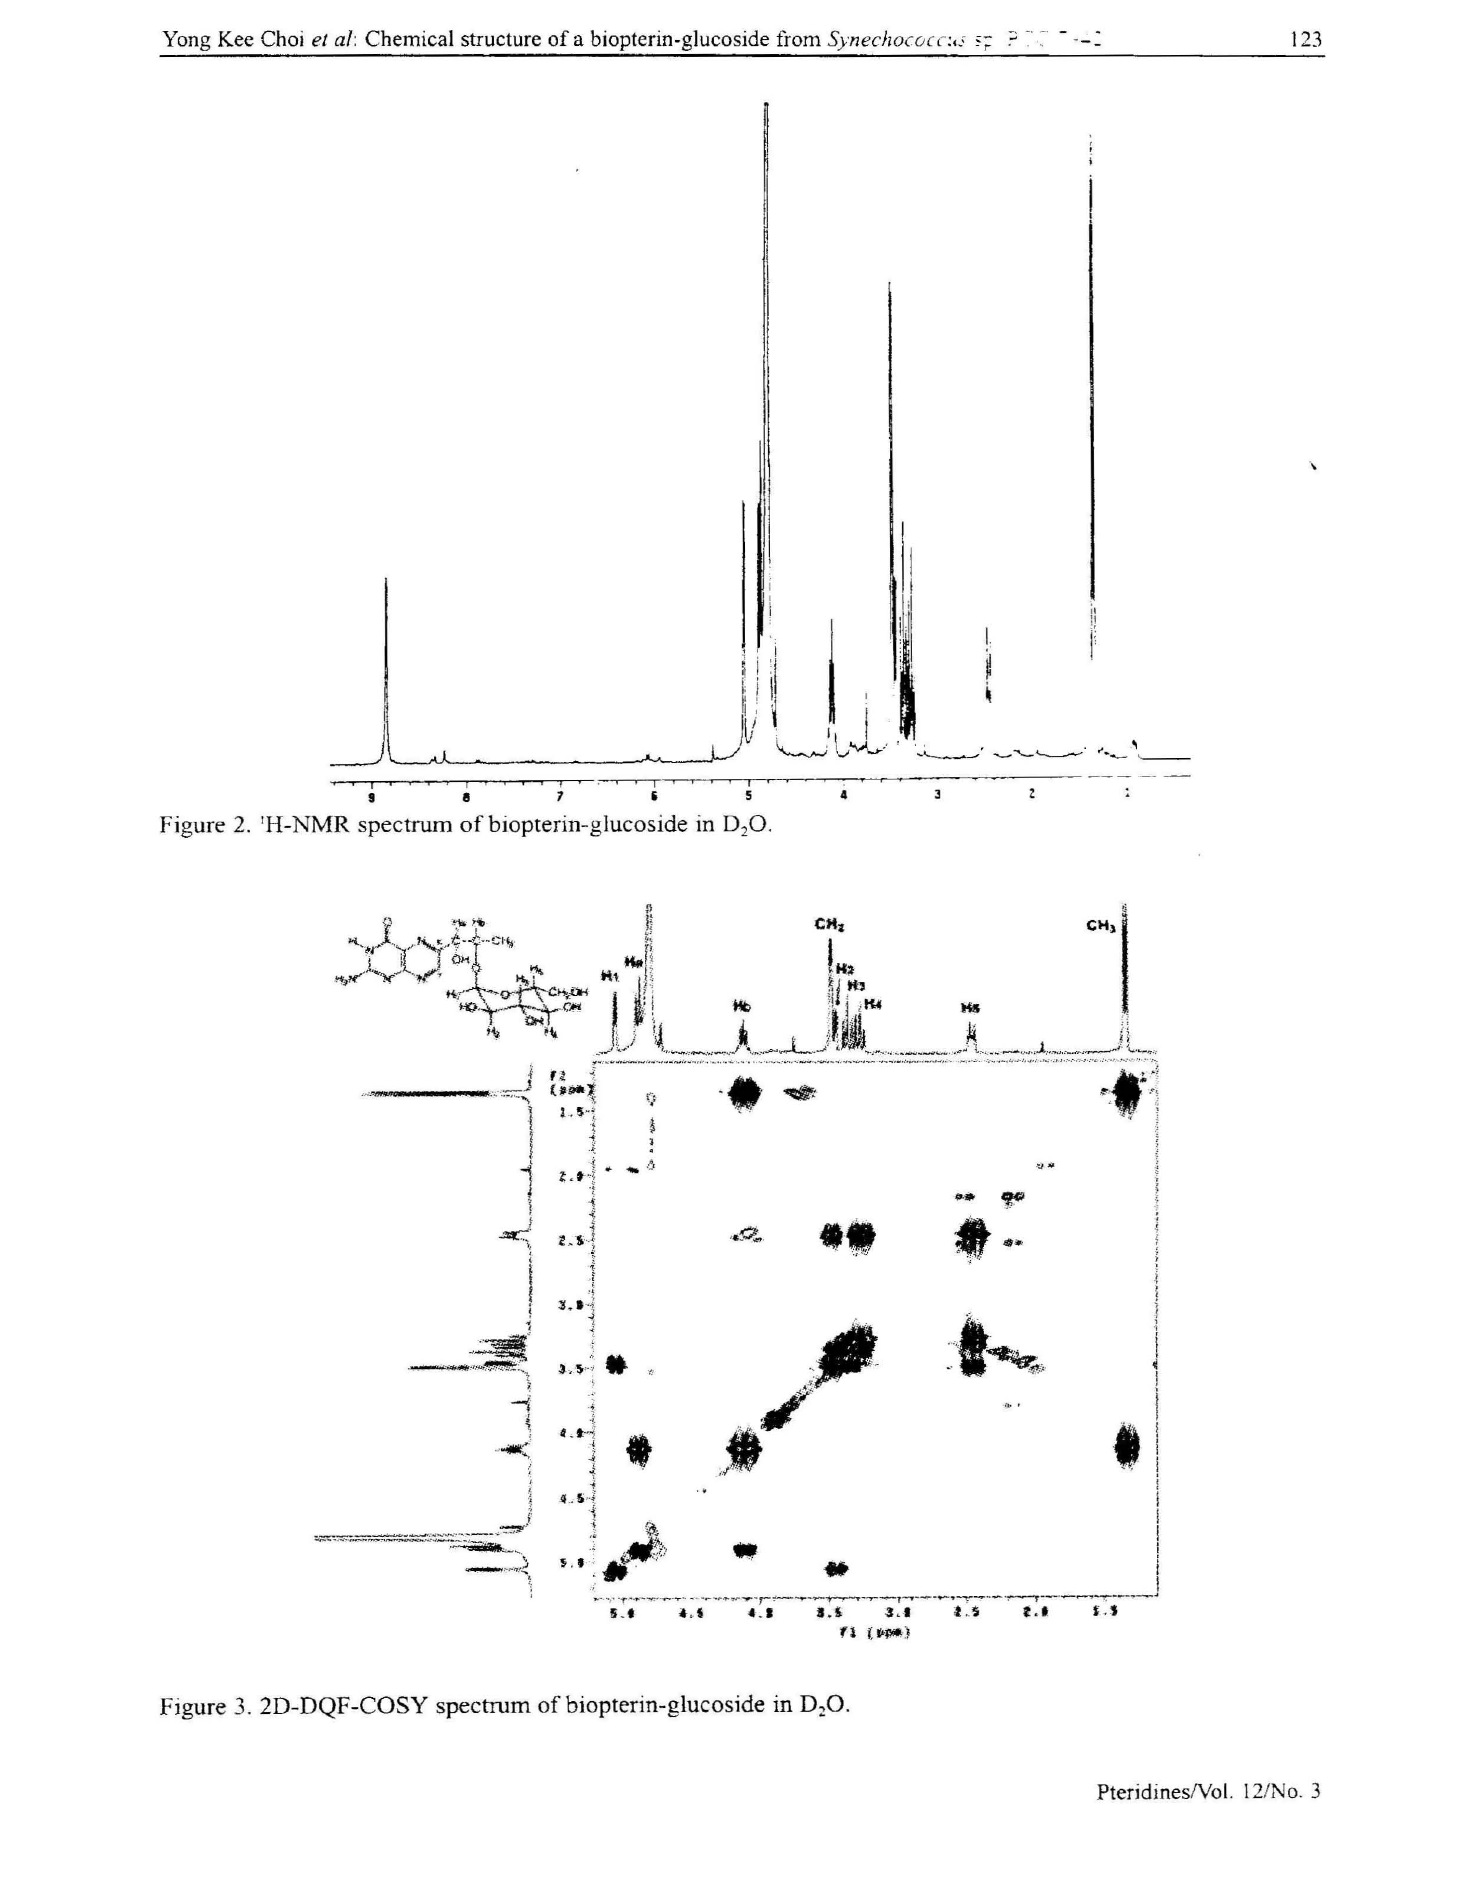
Figure 3. 2D-DQF-COSY spectrum ofbiopterin-glucoside in D